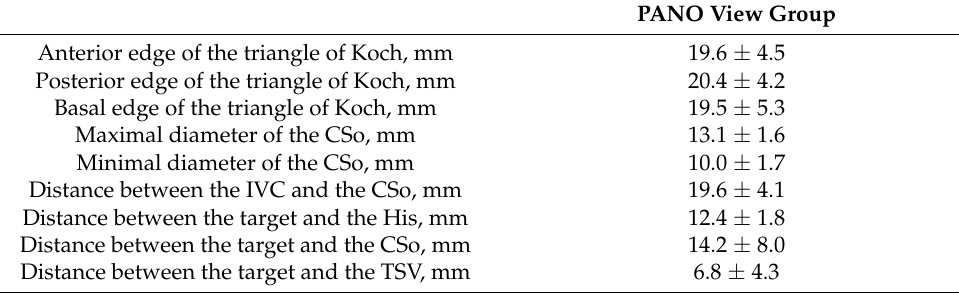
Table 3. Measurements of the triangle of Koch and other anatomic landmarks. PANO View Group Anterior edge of the triangle of Koch, mm 19.6 ± 4.5 Posterior edge of the triangle of Koch, mm Basal edge of the triangle of Koch, mm Maximal diameter of the CSo, mm Minimal diameter of the CSo, mm Distance between the IVC and the CSo, mm 19.6 ± 4.1 Distance between the target and the His, mm 12.4 ± 1.8 Distance between the target and the CSo, mm 14.2 ± 8.0 Distance between the target and the TSV, mm 6.8 ±